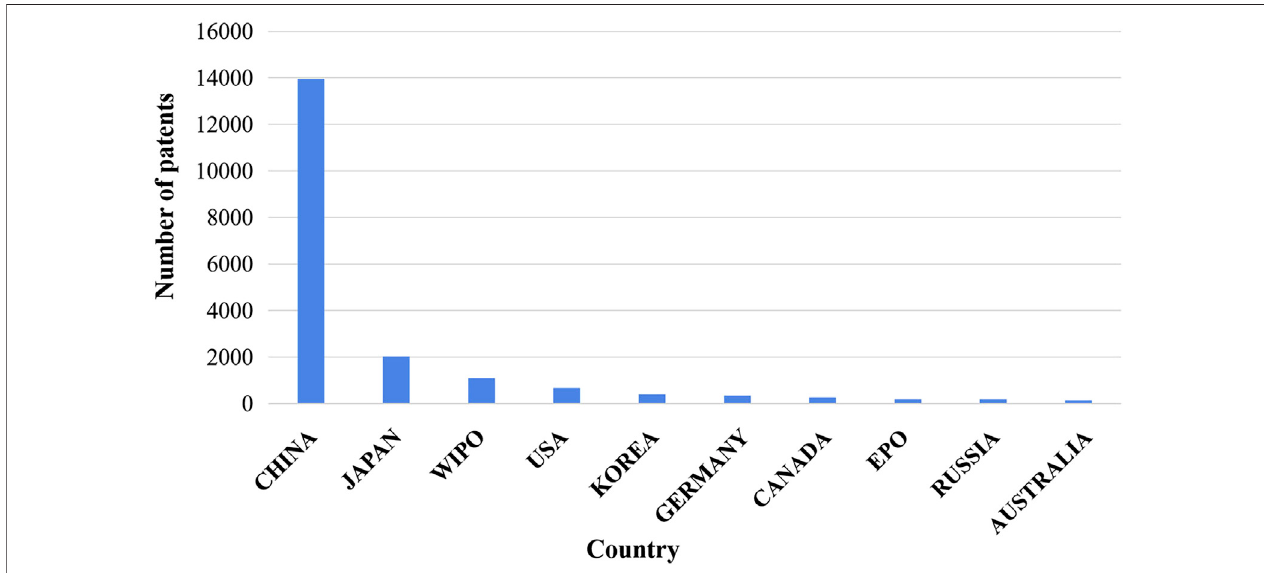
FIGURE 4 | Distribution of the top 10 countries or organizations in the number of patent applications for anticancer natural products. China ranked fi rst in the number of disclosed patents for natural anticancer drugs. WIPO, World Intellectual Property Organization; EPO, European Patent Of fi ce.